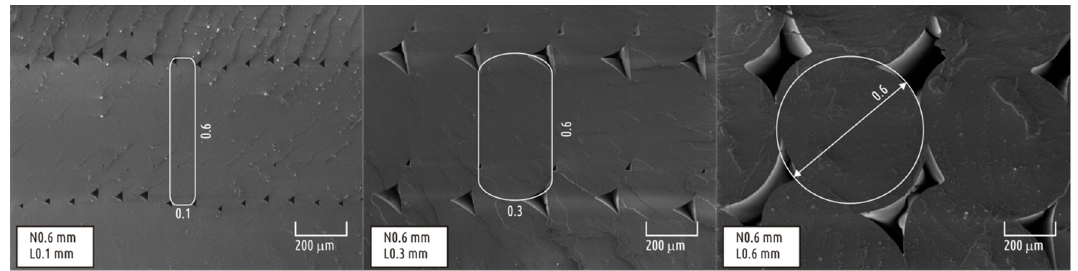
Figure 4. Transformation of an individual thread cross-section with layer thickness increase: idealized layer thread shape overlaid on SEM images.